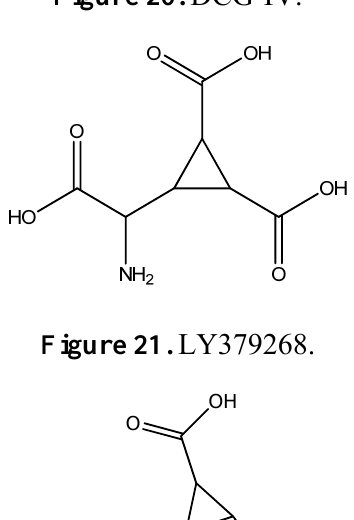
Figure 21. LY379268.